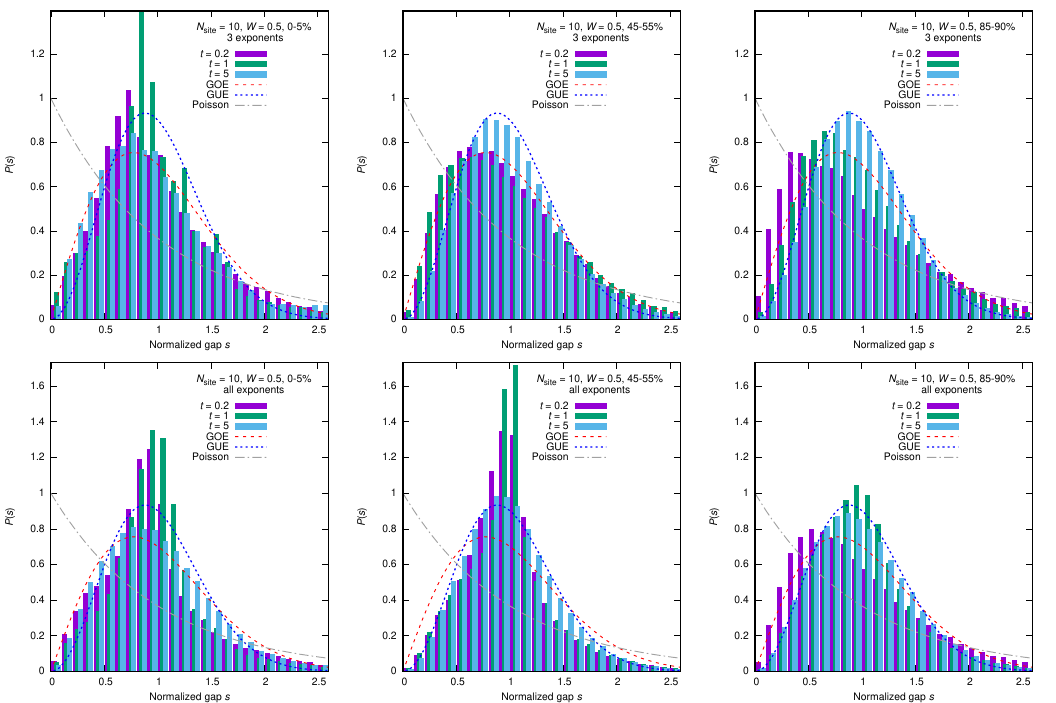
Figure 20 . XXZ model, distribution of the normalized gap P ( s ). N site = 10, W = 0 : 5 and 900 samples have been used for each case. The (cid:12)xed- i unfolding [upper] for the two gaps between the three largest exponents and [lower] for all gaps have been used for the Lyapunov exponents obtained using 0%{5% (left), 45%{55% (middle; the same as the left panel in (cid:12)gure 19), and 85%{90% (right) of the spectrum for each sample.